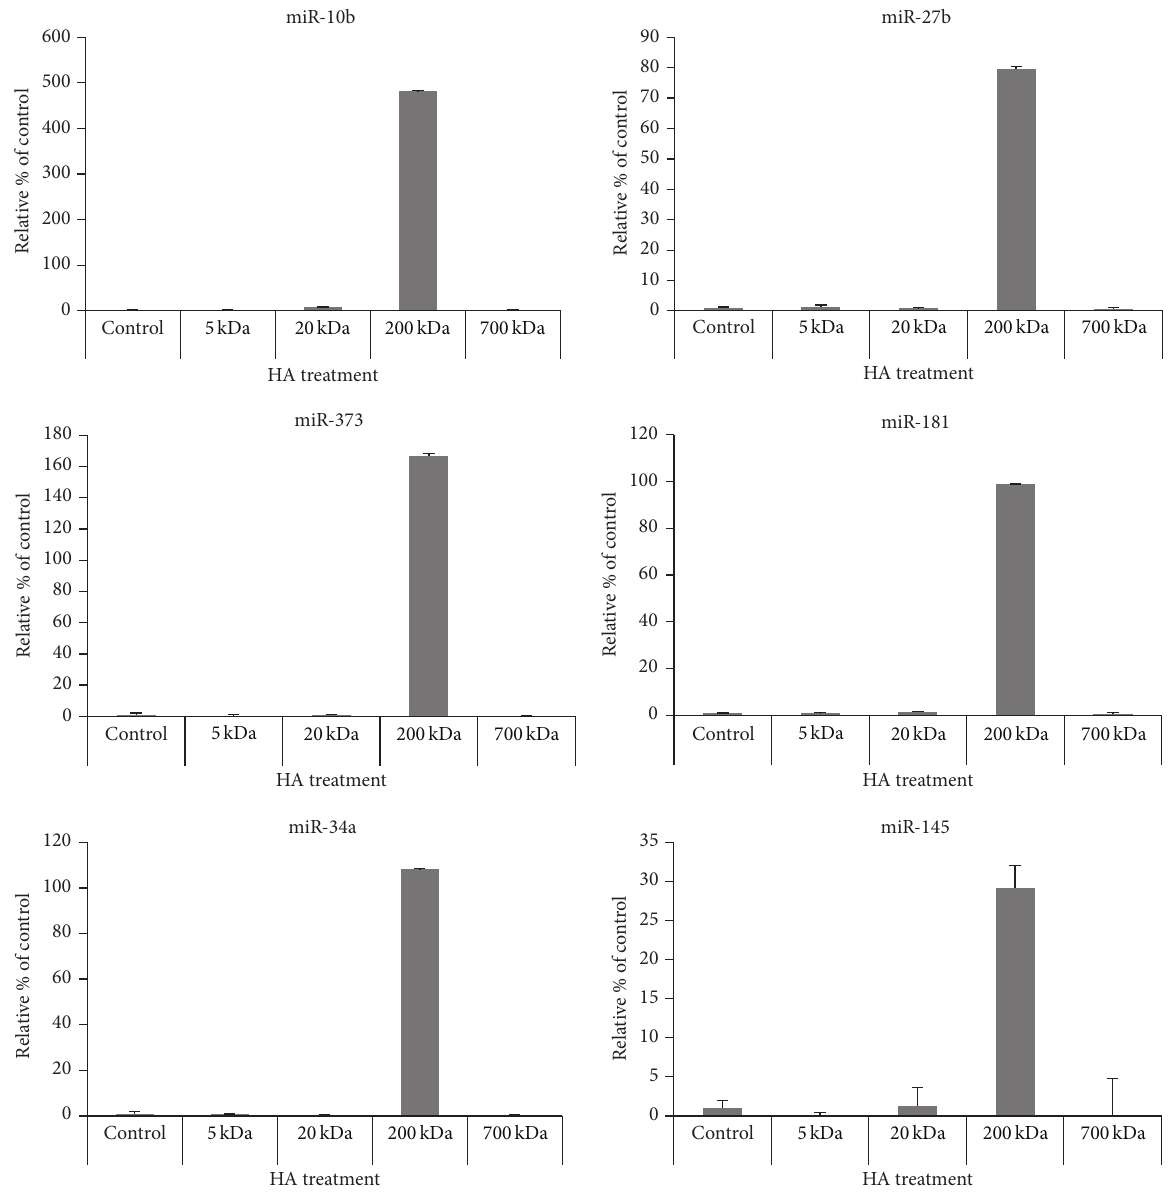
Figure 4: Detection of various miRNA expressions in CD 44 v 3 high ALDH high cells treated with different sizes of HA. Detection of miR-10b, miR-27b, miR-373, miR-181, miR-34a, and miR-145 production in CD 44 v 3 high ALDH high cells following the treatment with different sizes of HA (e.g., 5 kDa-HA, 20 kDa-HA, 200 kDa-HA, 700 kDa-Ha, and no HA) and analyzing by Q-PCR as described in Section 2.